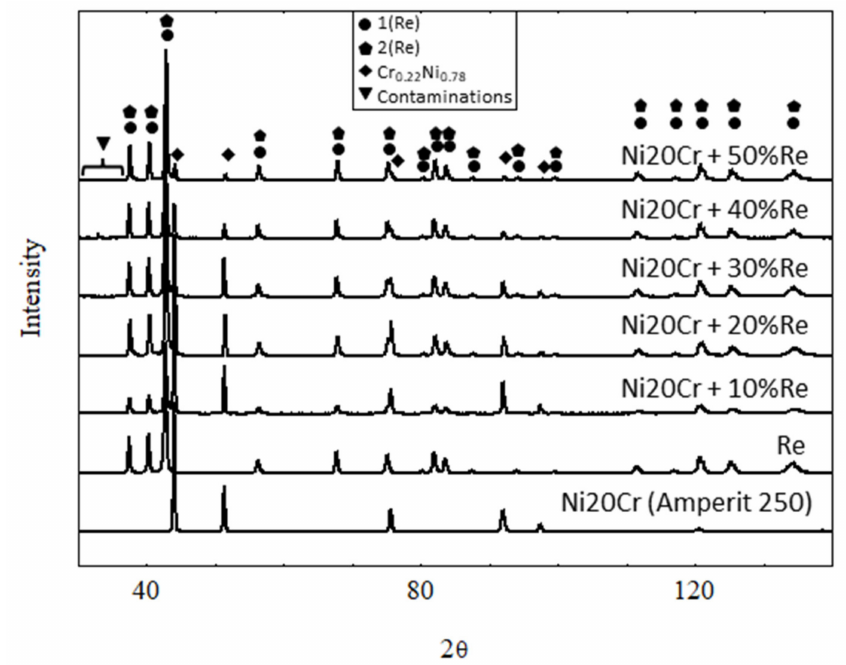
Figure 1. XRD diffraction pattern: NiCr (Amperit 250), rhenium and Ni20Cr + xRe powders.